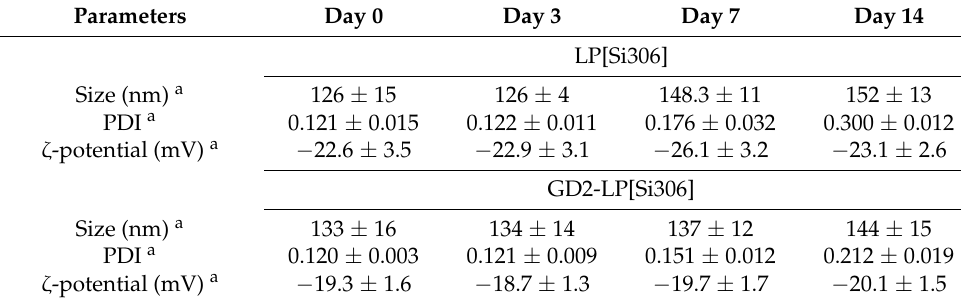
Table 2. Stability of LP[Si306] and GD2-LP[Si306] over a period of 14